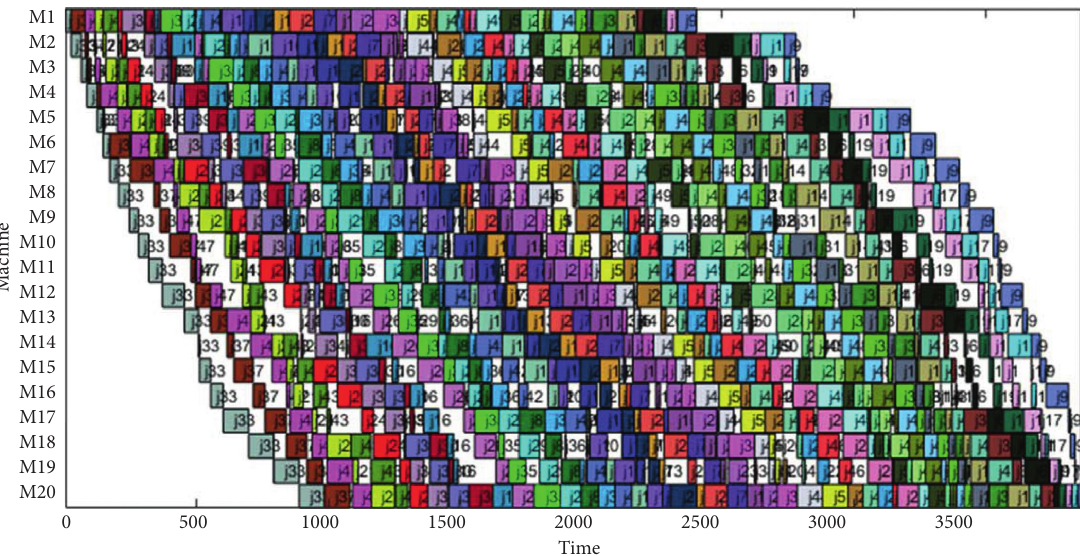
Figure 12: Gantt chart of the solution with IGSFLA (workpiece: 50, machine: 20, makespan: 3866.45).